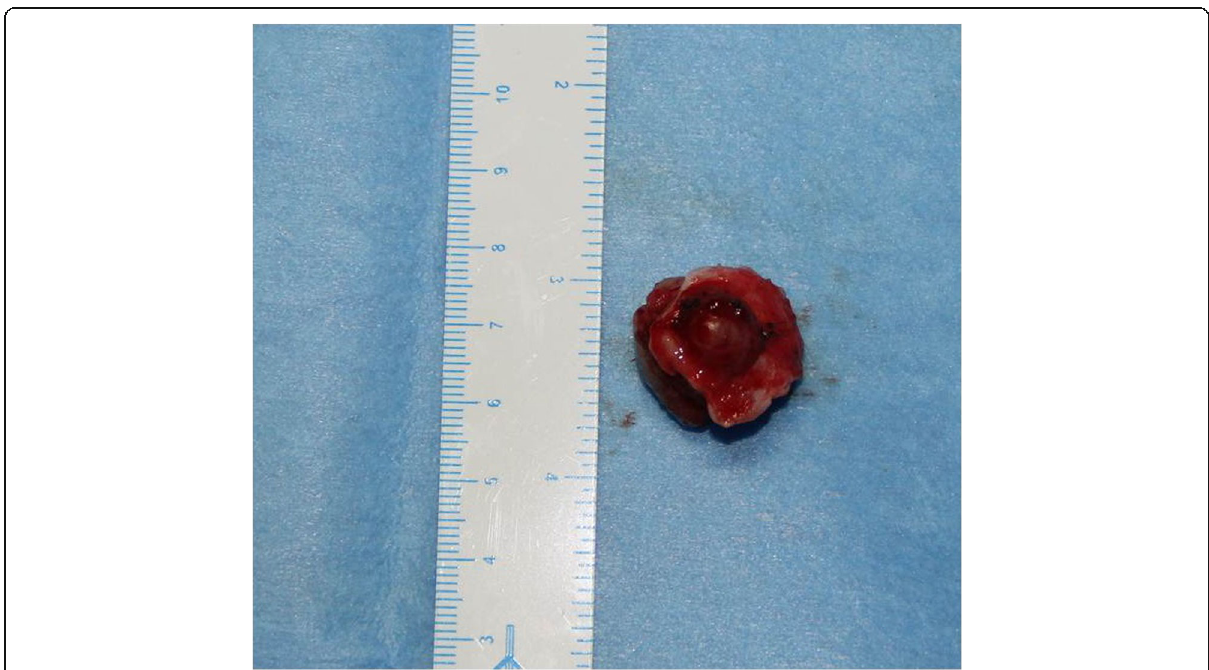
Fig. 3 Gross specimen of tracheal tumor with tracheal